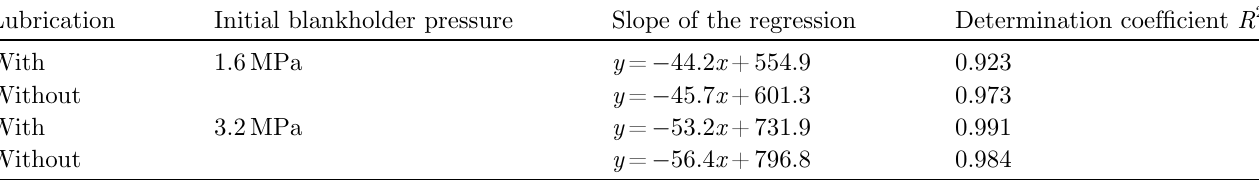
Table 4. Regression analysis of variation of the drawing clearance in the case of using bronze tool. Lubrication